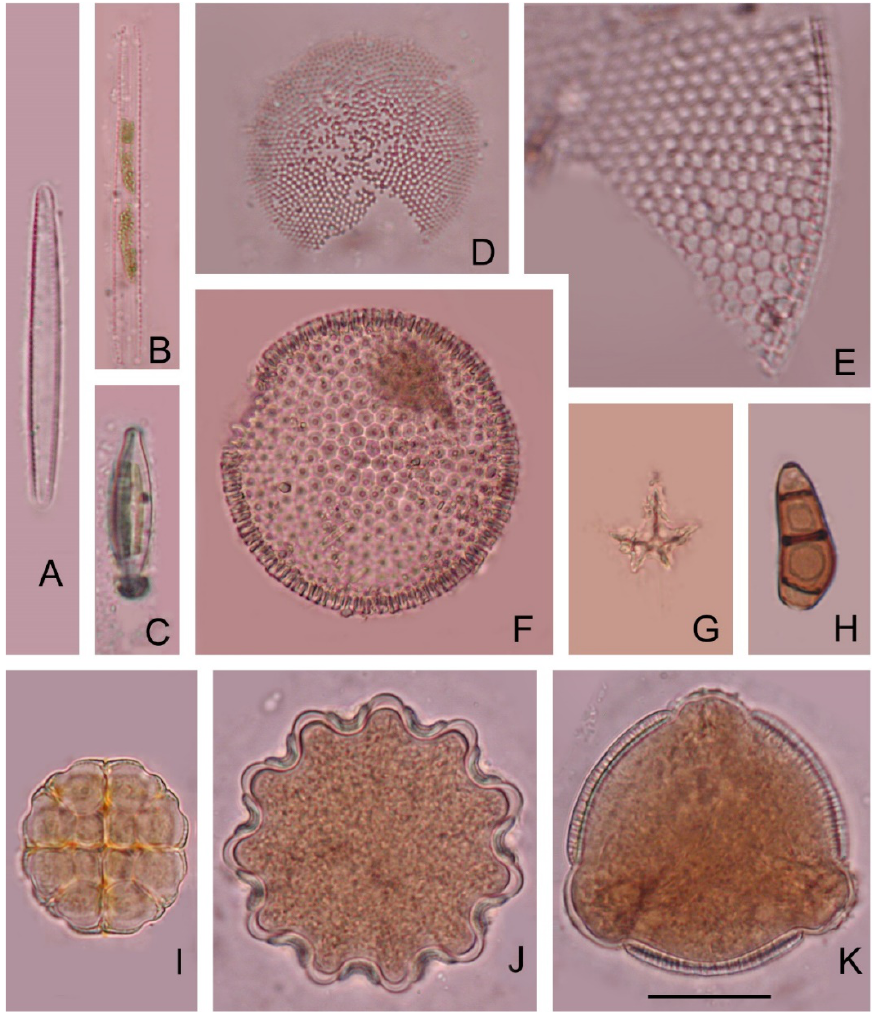
Figure 3. Diatoms, dinoflagellates, fungal spores, and pollen grains found in floral honey from Tunisia. ( A , B ). Thalassionema nitzschioides. ( C ). Mastogloia sp., ( D ). Actinocyclus divisus. ( E ). fragment of Coscinodiscus . ( F ). Coscinodiscus marginatus, ( G ). Actiniscus pentasterias. ( H ). Curvularia sp., ( I ). Acacia sp., ( J ). Polygalaceae sp., ( K ). Convolvulus sp., Scale bar: 20 µm.